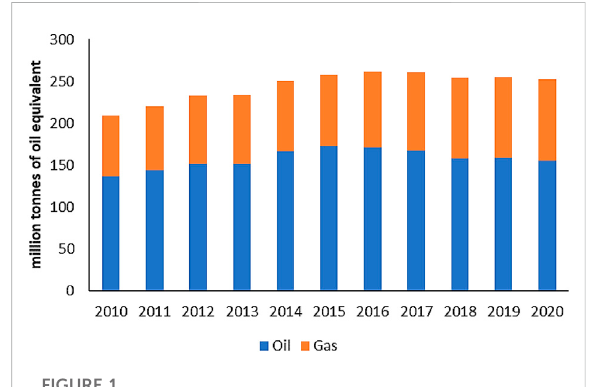
FIGURE 1 Saudi Arabia ’ s historical consumption of oil and natural